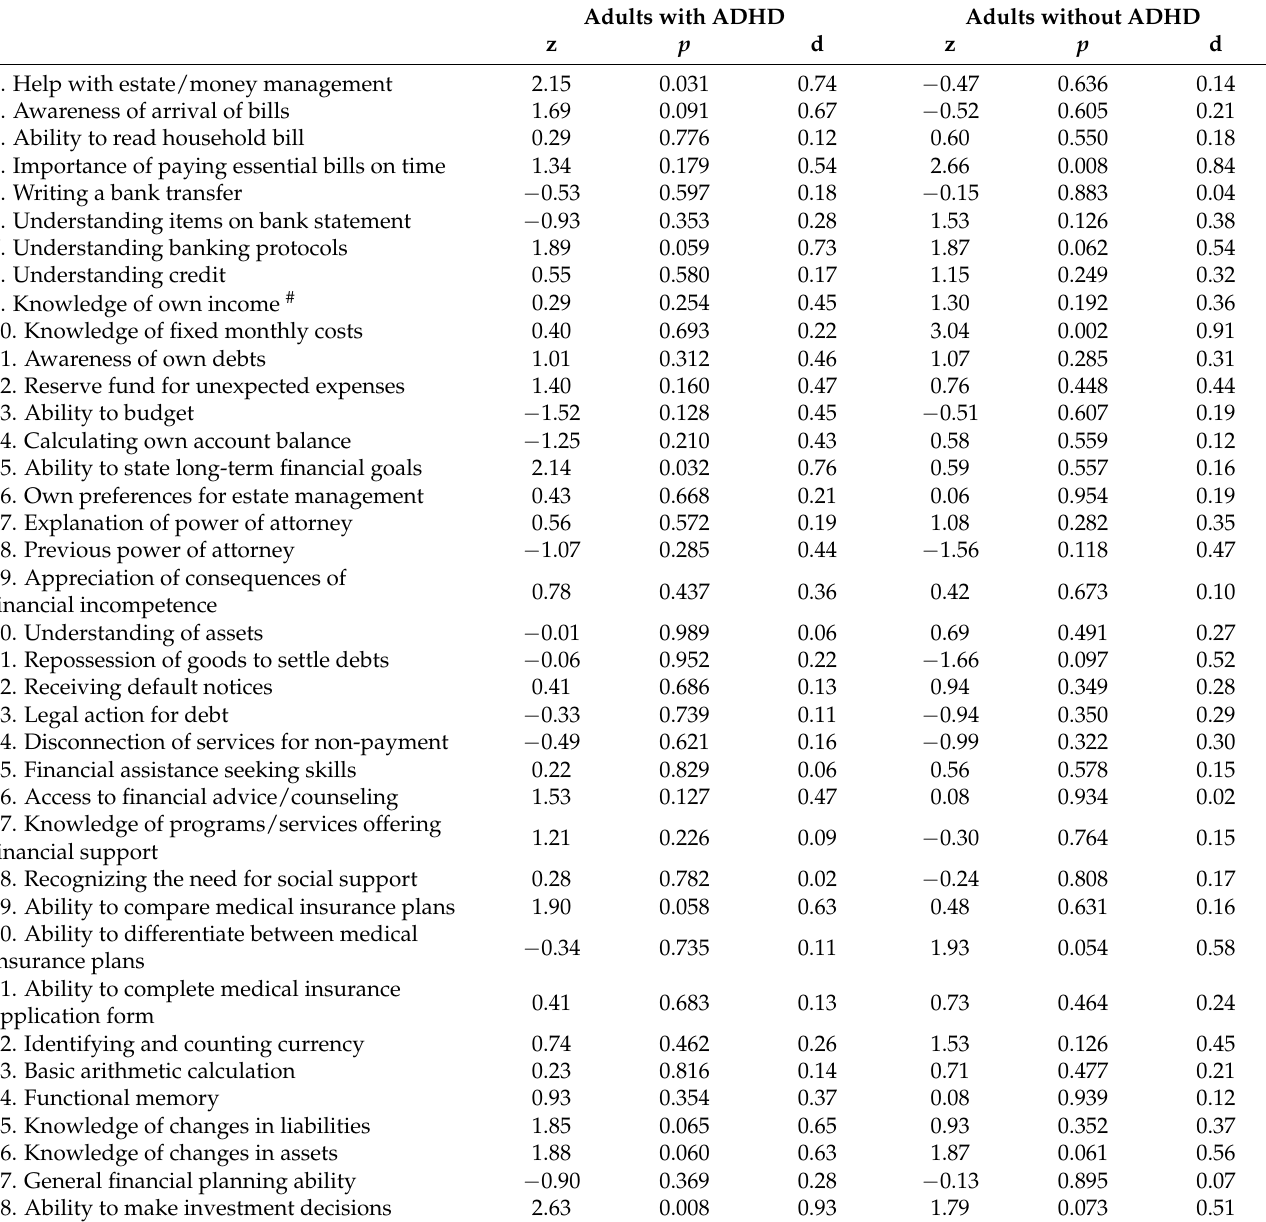
Table 4. Comparison of performance on FCAI items of adults with ADHD with a relatively low ( n = 31) and a relatively high income ( n = 13) and adults without ADHD with a relatively low ( n = 21) and a relatively high income ( n =